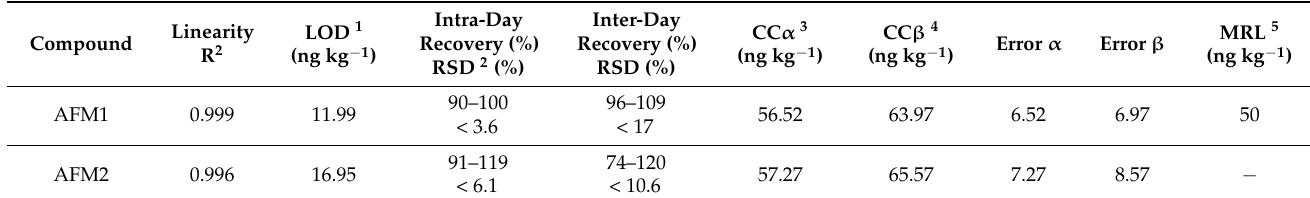
Table 1. Validation parameters for the determination of Aflatoxin M1 (AFM1) and Aflatoxin M2 (AFM2) in milk prior to the High-Performance Liquid Chromatography with Fluorescence Detector (HPLC-FL) method. Linearity Compound R